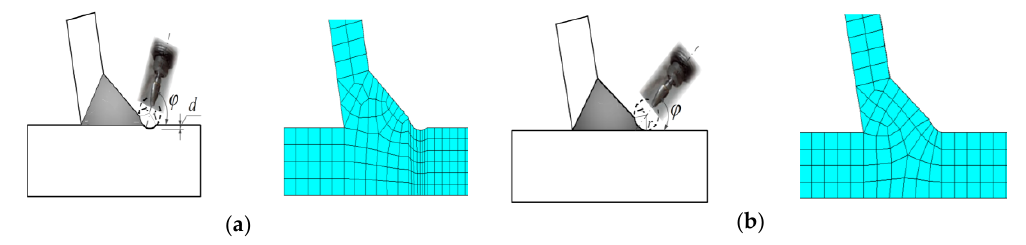
Figure 22. Grinding type. ( a ) Grinding type 1. ( b ) Grinding type 2. Table 8. The effects of different grinding types on fatigue life.